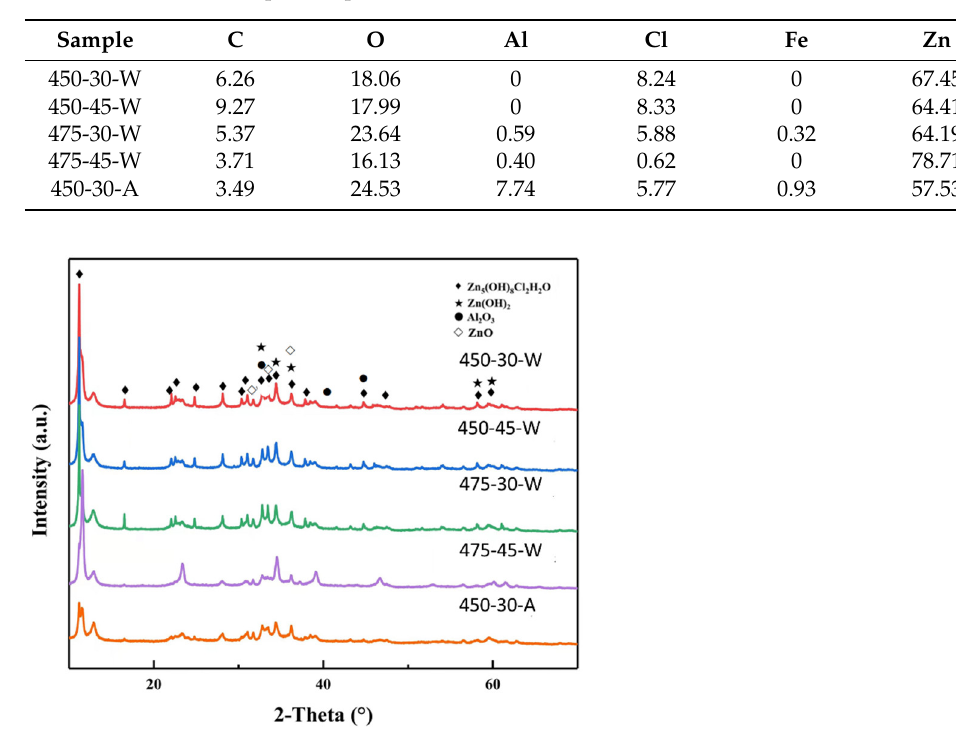
Figure 9. SEM morphology of the hot dip coating after 120 d corrosion with different process pa- rameters, ( a ) 450-30-W; ( b ) 450-45-W; ( c ) 475-30-W; ( d ) 475-45-W; ( e ) 450-30-A. Table 10. Elemental composition (wt%) of the surface of the hot dip coated steel wire after 120 d corrosion with different process parameters.